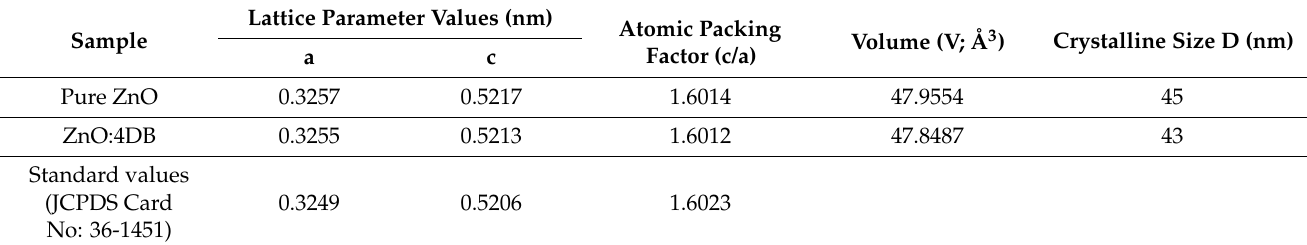
Table 1. Lattice parameter values of the pure ZnO and ZnO:4DB